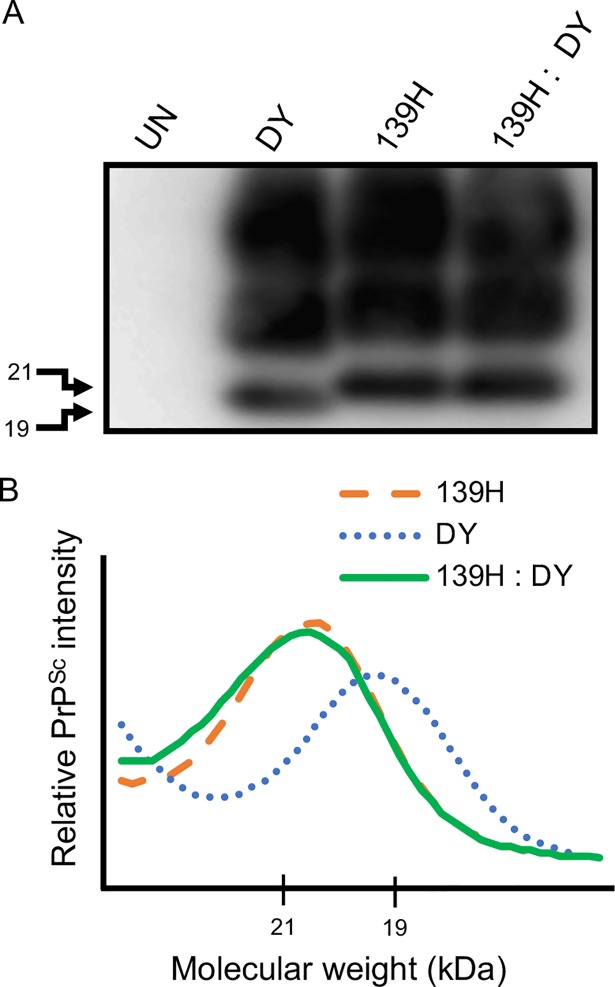
Preservation of strain specific PrPSc migration following PMCA.Western blot analysis (A) and PrPSc migration analysis (B) of PK digested brain material from hamsters inoculated with either 10th serial round PMCA reactions seeded with uninfected (UN) brain homogenate, DY, 139H or an equal mixture of DY and 139H-infected brain homogenate.